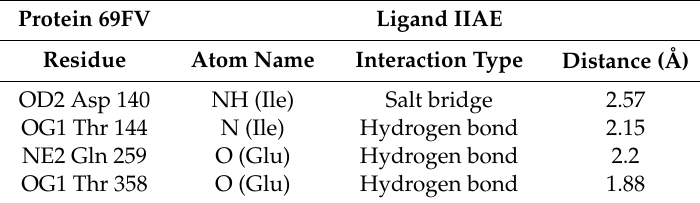
Table 2. IIAE docking results.